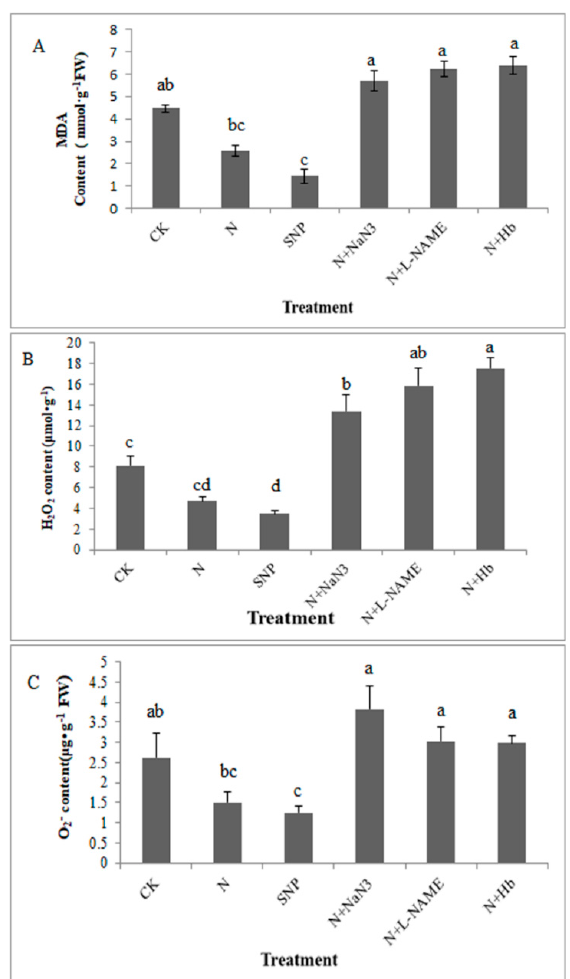
+ :NO − ratio on membrane lipidation damage in mini Chinese cabbage Figure 1. Effects of NO and NH 4+ :NO 3 − ratio on membrane lipidation damage in mini Chinese cabbage Figure 1. E ff ects of NO and NH 4 3 leaves under low light stress. The seedlings cultivated in black containers filled with di ff erent